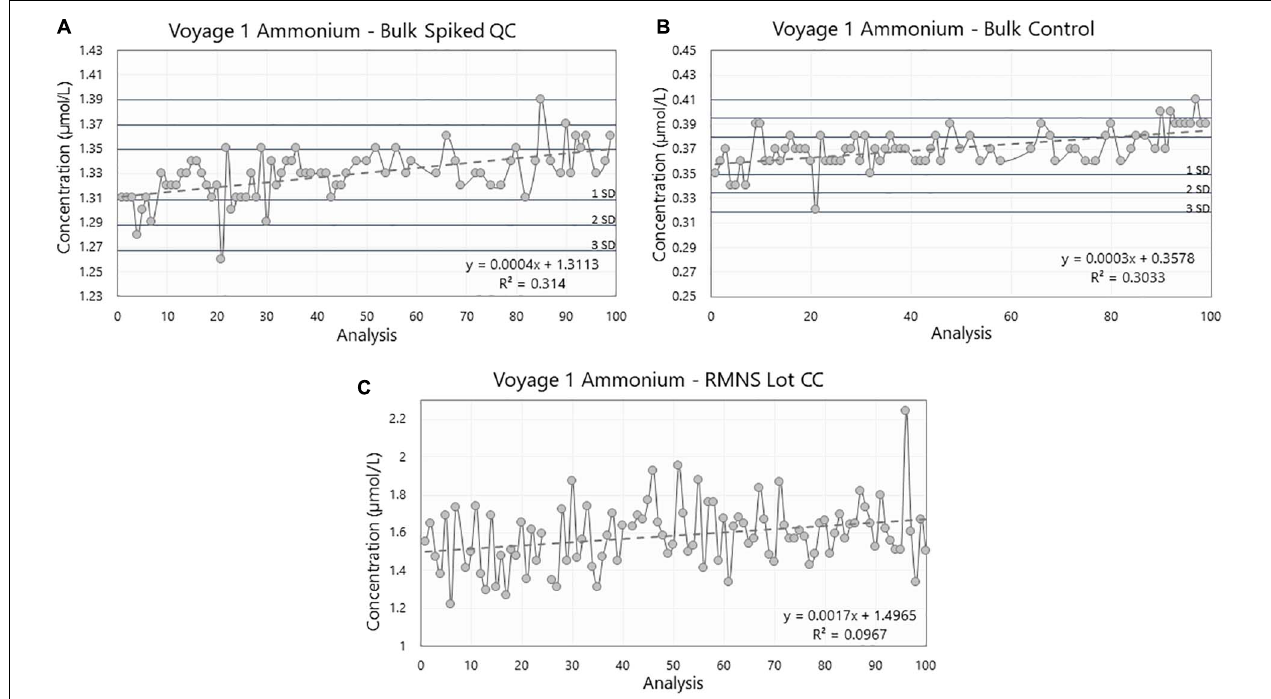
FIGURE 7 | Ammonium concentration (in µ mol/L) in (A) the Spiked QC, (B) the Control, and (C) the reference material for nutrients in seawater (RMNS) lot CC during the voyage 1 on board the RV Investigator. Horizontal lines are the standard deviation (SD) multiplied by 1, 2, and 3 centered around the mean which act as QC